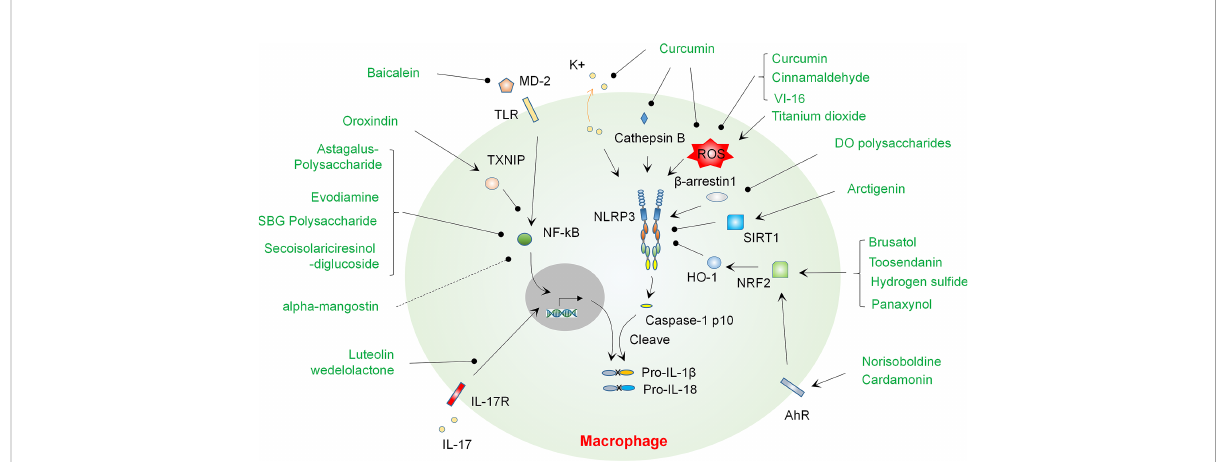
FIGURE 2 Natural compounds regulate NLRP3 in fl ammasome activation and progression of colitis via modulating various mechanisms. A number of natural compounds such as Baicalein suppress colitis by regulating priming of the NLRP3 in fl ammasome through modulating NF- k B activation, mainly via blocking MD-2 binding to TLR4 or inducing TXNIP expression. Blockade of IL-17R signaling by Luteolin or Wedelolactone may contribute to suppression of the priming signal of NLRP3 in fl ammasome. A handful of compounds including Curcumin can ameliorate colitis by suppressing the NLRP3 in fl ammasome via regulating ROS production, K+ ef fl ux or cathepsin B release. Polysaccharides from DO may suppress b -arrestin-1 and thus inhibit the activation of NLRP3 in fl ammasome. A number of compounds such as Norisoboldine can promote activation of AhR and then activate NRF2 or SIRT1 signaling, which contribute the suppression of the NLRP3 in fl ammasome and amelioration of colitis. DO, Dendrobium of fi cinale.